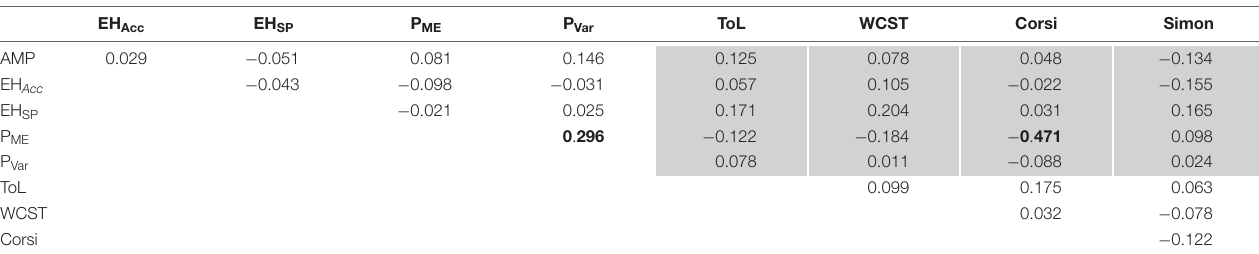
flexibility; Corsi, Working memory; ToL, Planning and problem-solving; Simon, Inhibitory control. TABLE 4 | Partial correlations controlled for age between sensorimotor skill components and measures of executive functioning in adults. EH Acc EH SP P Var